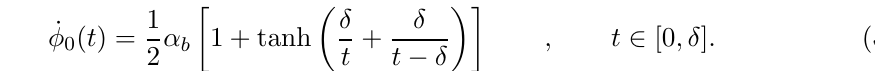
hO (cid:30) ( t ) i / (cid:14) (cid:0) 2 (blue dashed) for the t 2 [0 ;(cid:14) ]